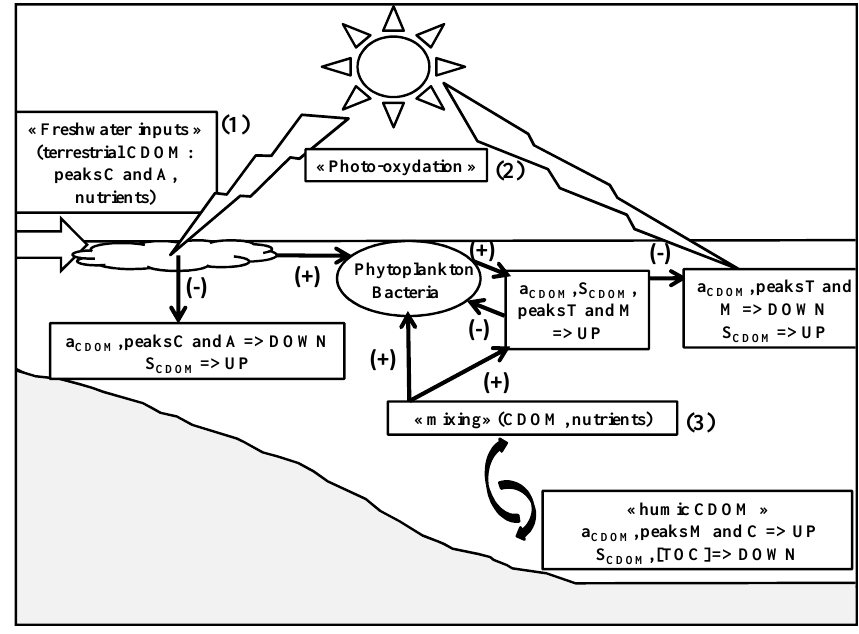
Fig. 8. Synthesis of processes (Rhˆone River plume intrusion (1), photo-oxydation of CDOM (2) and water mixing (3)) driving surface CDOM dynamic and content in the Bay of Marseilles and their direct and indirect effects (positive or negative) on CDOM optical properties.